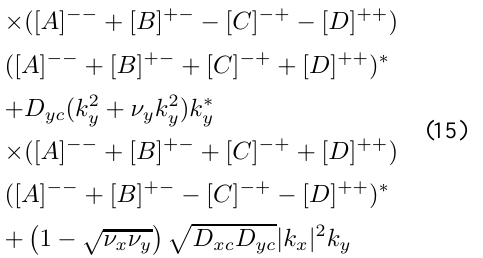
Fig. 12. The approximate energy density distribution of the orthotropic plate when f = 5 kHz and η = 0 . 02 . The reference energy density is 1 × 10 − 12 J/m 2